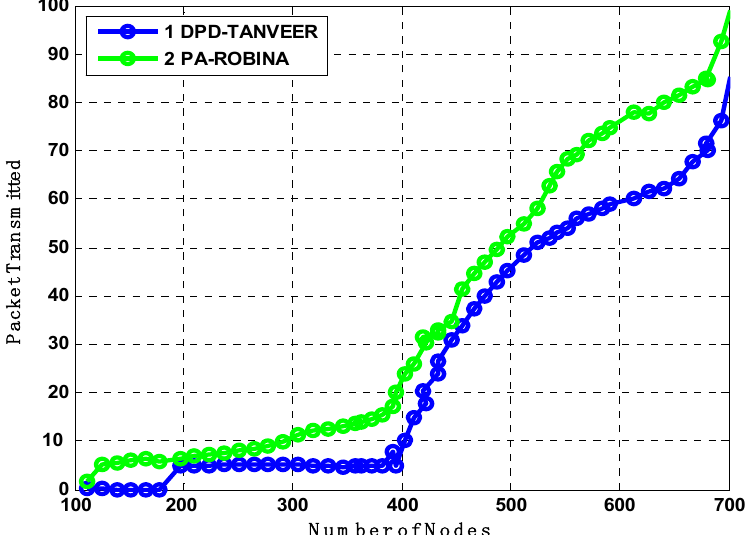
Figure 14. Analysis of the number of dead nodes compared with DPD-TANVEER and PA-ROBINA.